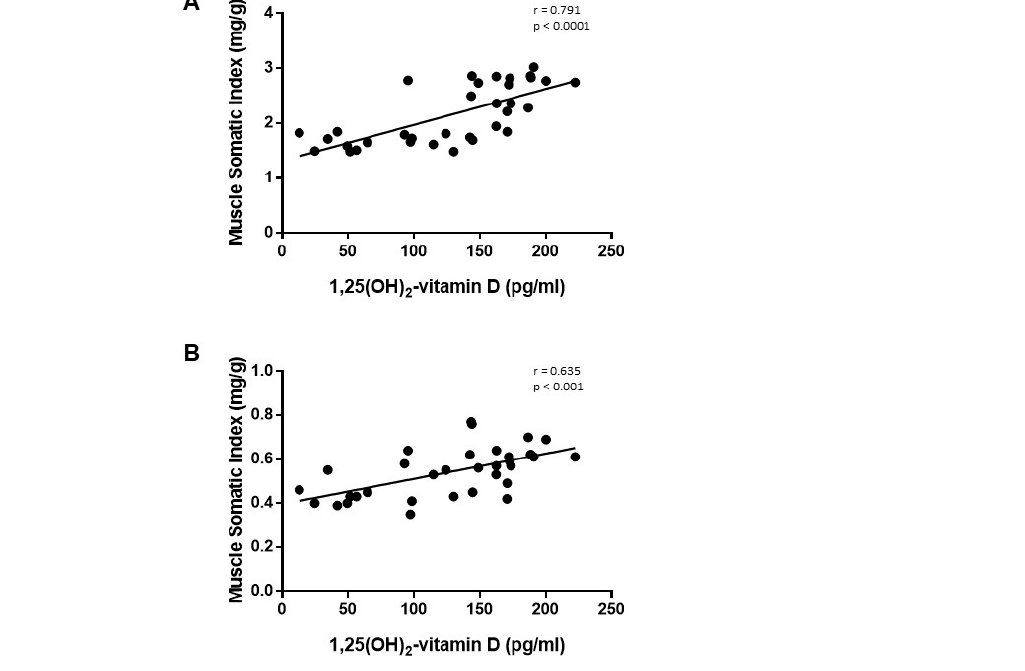
Figure 6. Correlation study (Pearson test) between plasma concentrations of 1,25(OH) 2 -vitamin D vs. muscle somatic index in ( A ) tibialis cranialis and ( B ) soleus muscles of control and energy-restricted rats.